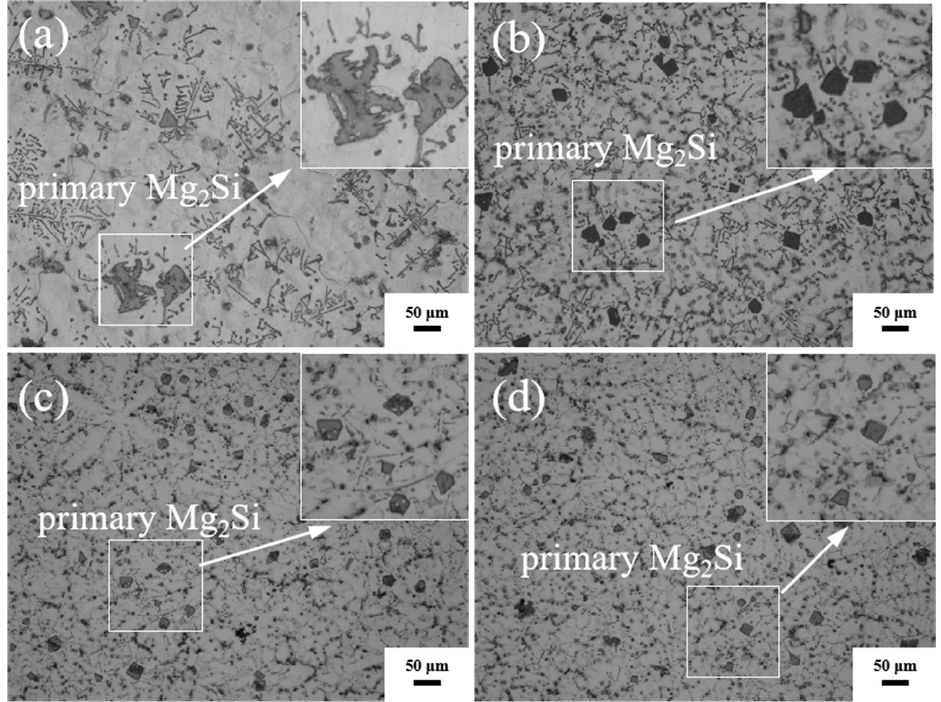
Figure 2. Optical micrograph of the alloys and composites, ( a ) M-AC, ( b ) 1-COM, ( c ) 3-COM, and ( d ) 5-COM showing the morphology and distribution of the primary Mg 2 Si. (Scale bar = 50 μ m).